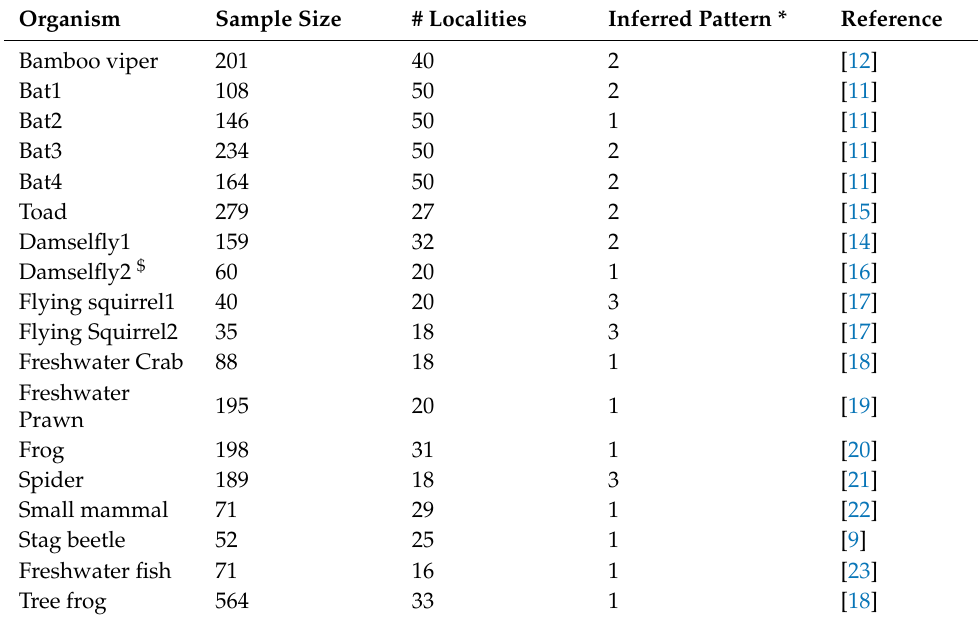
Table 1. Examples of Taiwanese phylogeographic studies and their evolutionary inferences.